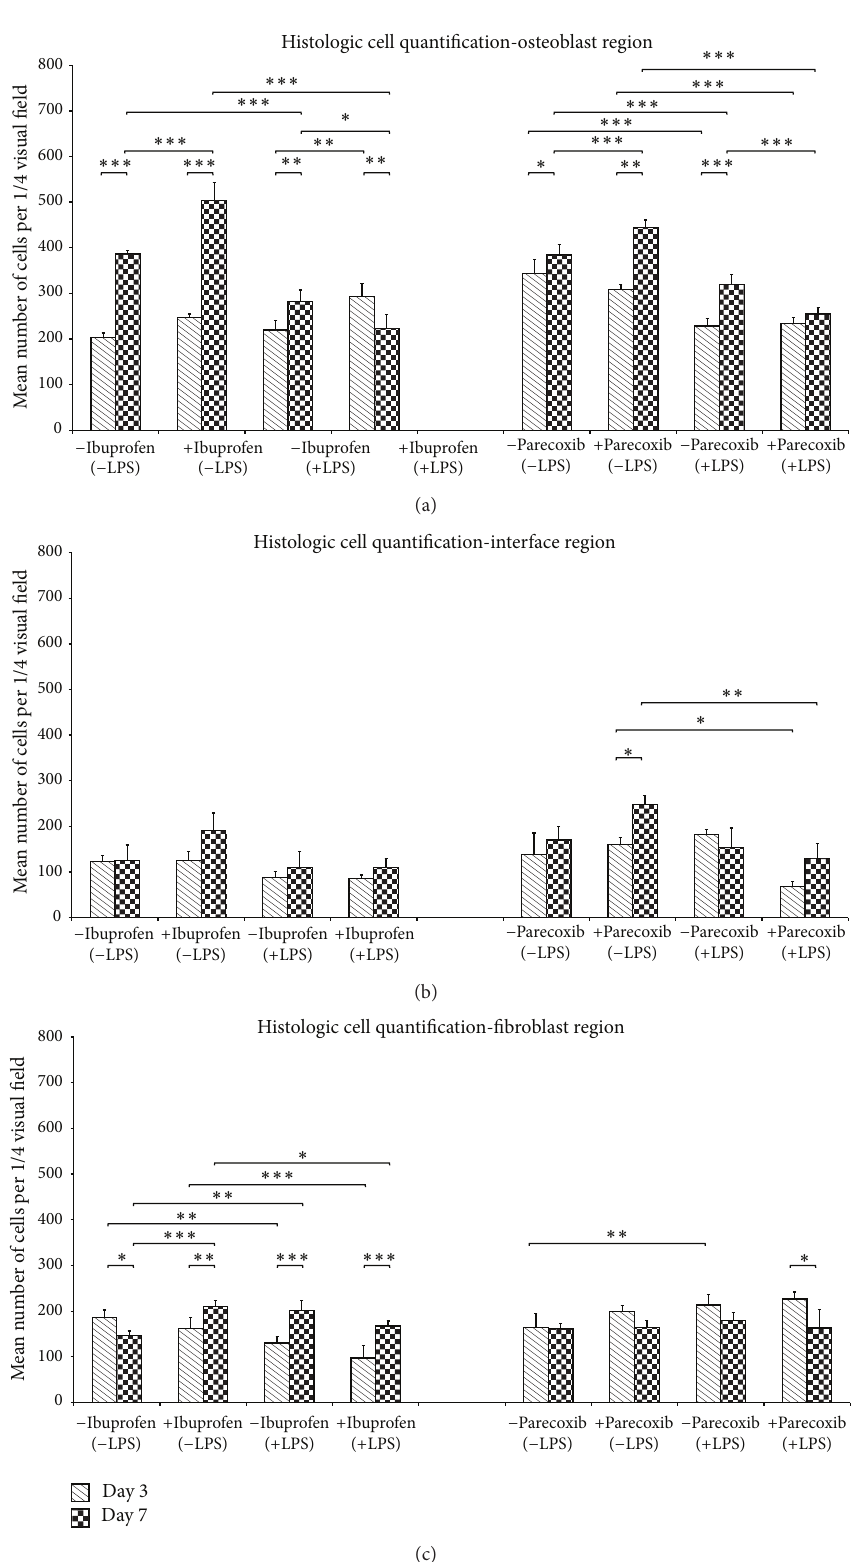
Figure 6: (a)–(c) Effects of ibuprofen and parecoxib on region-specific cellular outgrowth during bone-tendon healing in vitro . DMSO: dimethyl sulfoxide; LPS: lipopolysaccharide; NaCl: sodium chloride. 𝑃 values are provided as follows: ∗ 𝑃 < 0.05 , ∗∗ 𝑃 < 0.01 , and ∗∗∗ 𝑃 < 0.001